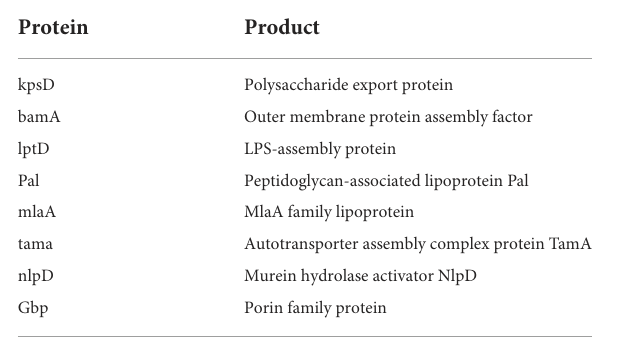
TABLE 1 Selected proteins in the core and soft-core genes of HPS.